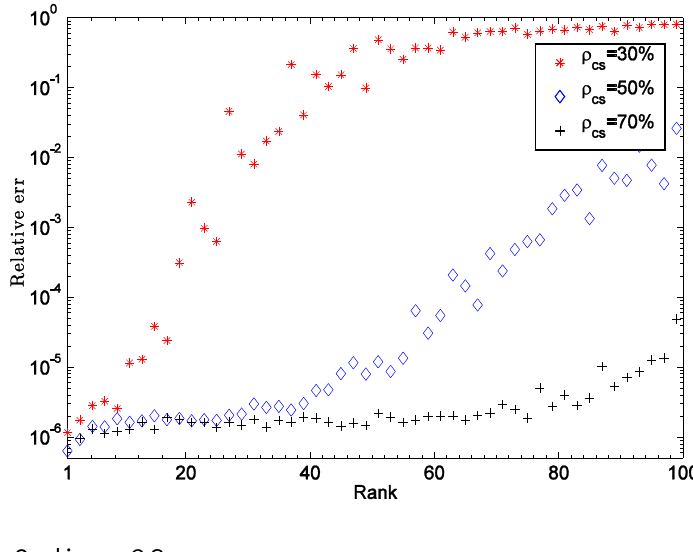
Figure 3. Sparse recovery performance with respect to the rank of fixed